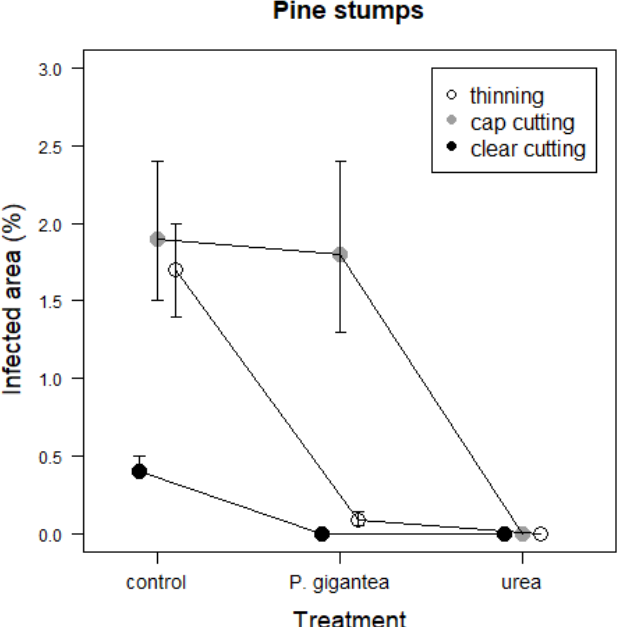
Figure 2. Area covered by Heterobasidion sp. (%) in the control, P. gigantea , and urea treatments in Scots pine stumps in thinning, cap cutting, and clearcutting. Predicted values with standard errors of means (SE) in different treatments and harvesting methods based on the estimated model are presented.